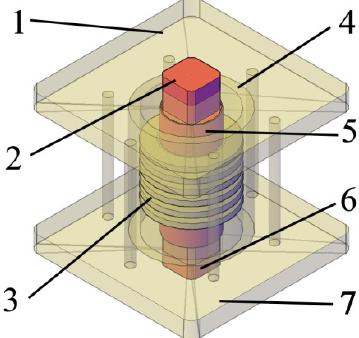
Figure 1. Structure of the CS: 1 Upper Epoxy Plate, 2 Upper Conductor, 3 Support Epoxy, 4 Epoxy Barrel, 5 Barrel Conductor, 6 Lower Conductor, 7 Lower Epoxy Plate.